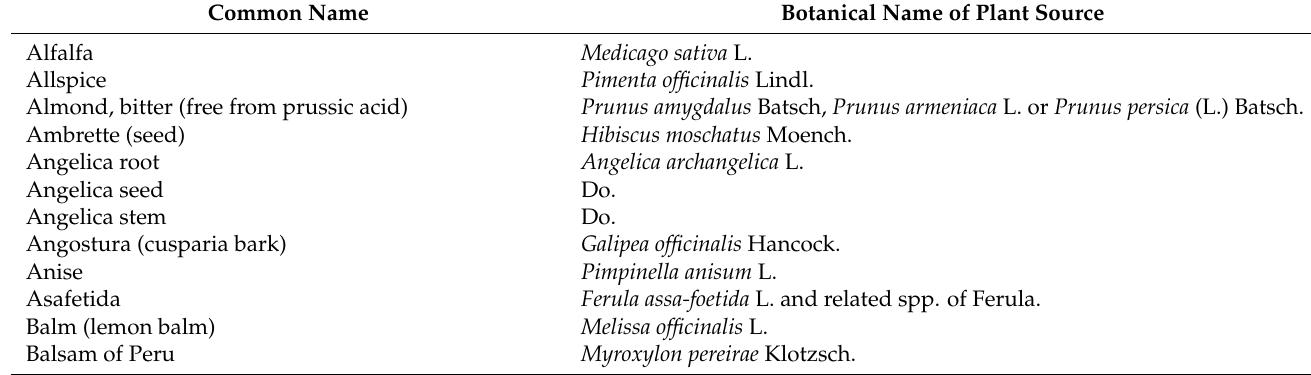
Table 2. EOs generally recognized as safe by Food and Drug Administration (FDA). Source: https://www.ecfr.gov/cgi- bin/text-idx?SID=69c1693f1fe5cddde23bdc34d0731b05&mc=true&node=pt21.6.582&rgn=div5#se21.6.582_120 (accessed on 10 February